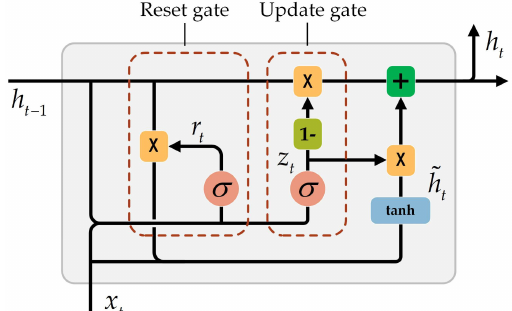
Figure 1. Gated recurrent unit (GRU) neural network unit structure. x t is the current input, z t is the update gate, r t is the reset gate, ˜ h t is the candidate hidden state of the currently hidden node, h t is the current hidden state, x t is the input of the current neural network, and h t − 1 is the hidden state at the previous moment. σ is the activation function sigmoid . ˜ h t records all important information through the reset gate and input